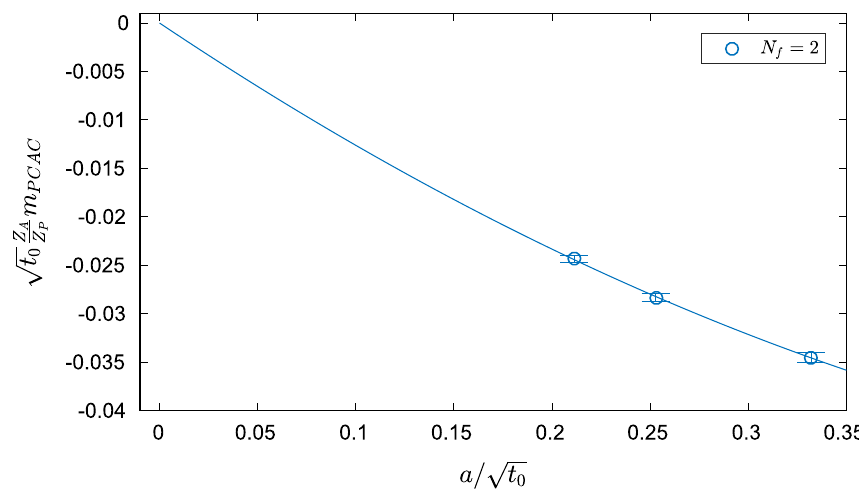
Fig. 1 The standard mass contribution to the renormalized quark mass, which vanishes in the continuum